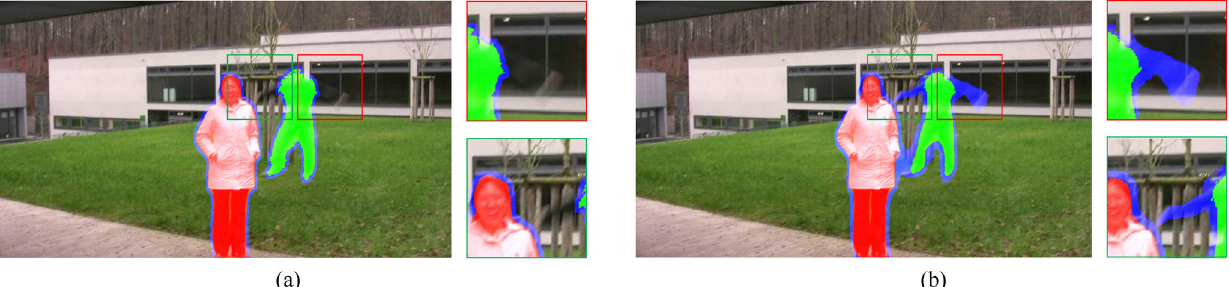
Fig. 3 Advantages of using the smart dilation mask, a smart border layer in the output map of our multi-OSVOS network. (a) Border obtained by simply dilating the output map of the network: some parts of the objects are not covered. (b) Border layer learned by the network: the transition region is